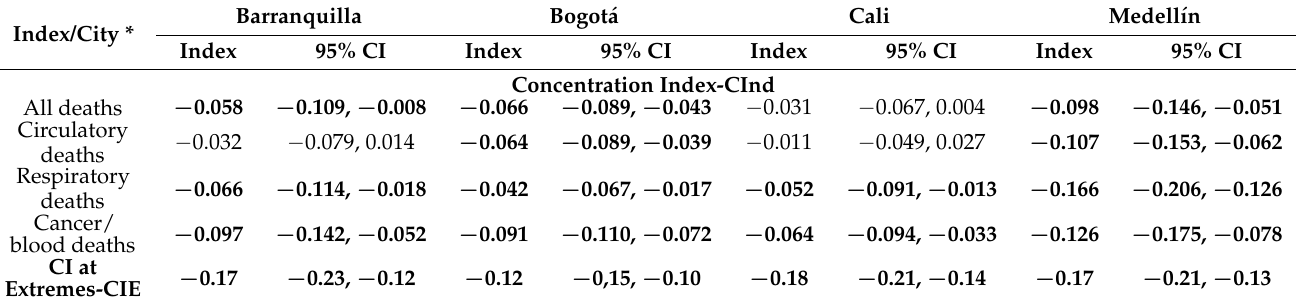
Table 2. Concentration indexes (CInd) of mortality for all deaths and specific causes of death by multidimensional poverty index (MPI) for four cities in Colombia,